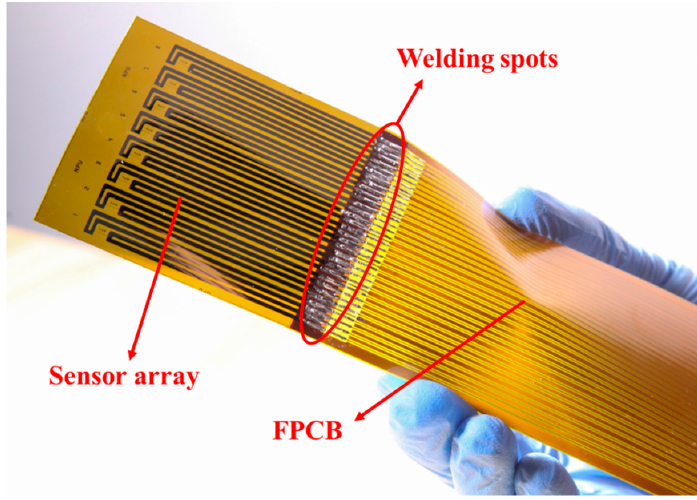
Figure 8. Sensors are connected to the flexible printed circuit board (FPCB) by welding.